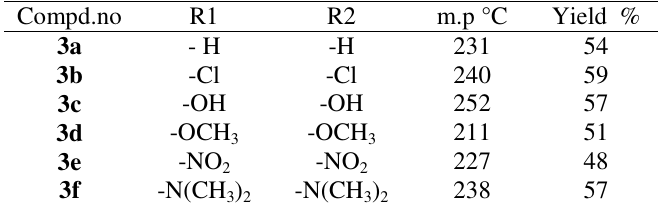
Table 1. Characterization data of the compounds